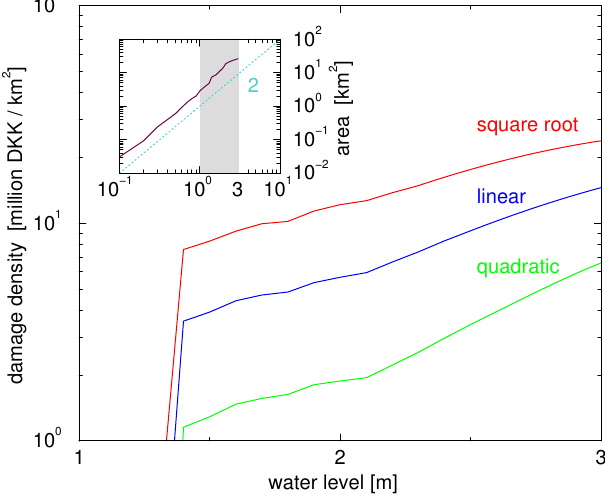
Fig. 6. Macroscopic damage functions assuming different build- ing damage functions. The estimated direct monetary damage is plotted against the water level, whereas the central blue line corre- sponds to the non-coarse-grained case (using 4 nearest neighbours). The grey bands represent the range between highest and lowest of all 14 combinations. We assume square root, linear, or quadratic building damage functions (from top), Eqs. (1), (3), and (4), see Fig. 2. The result for the linear building damage functions is the same as in Fig. 5. The inset shows the curves in semi-logarithmic scale.